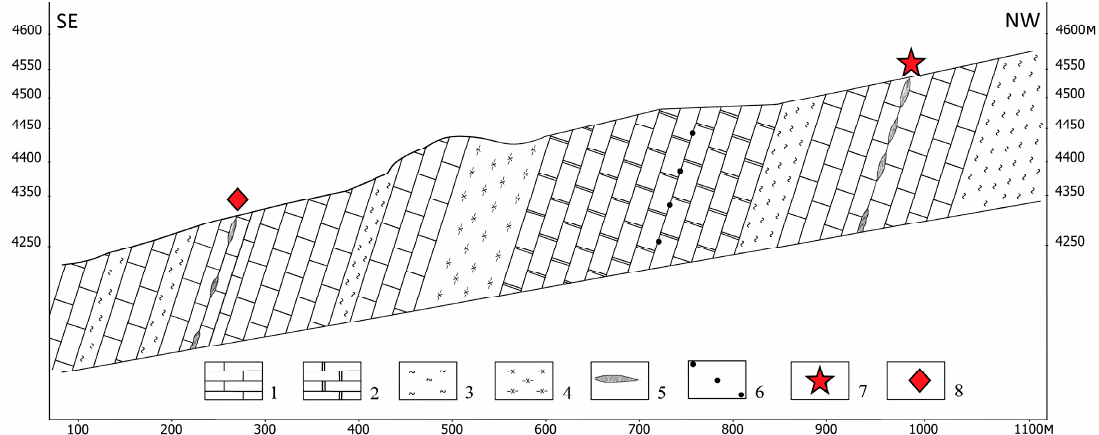
Figure 3. A geological cross-section of the upper part of the Sarydzhilgin suite through the Snezhnoe deposit and the ruby occurrences of Lagernoye and Alenushka: 1—calcitic marble and 2—dolomitic marble (dip angle is 60–70°), 3—high alumina crystalline schists, 4—diopside–scapolite rocks, 5—ruby deposits–micaceous lenses, 6—monomineralic ruby mineralization. 7—Snezhnoe deposit. 8—Alyonushka ruby occurrence. The cross-section is modified after [20]. The area above of the upper curve represents the modern topographic surface, whereas the white area below is the cutoff of the geological cross-section.